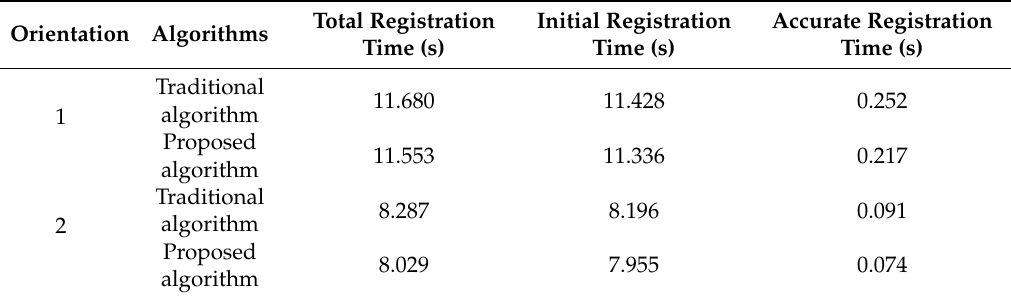
Table 5. Registration time of different